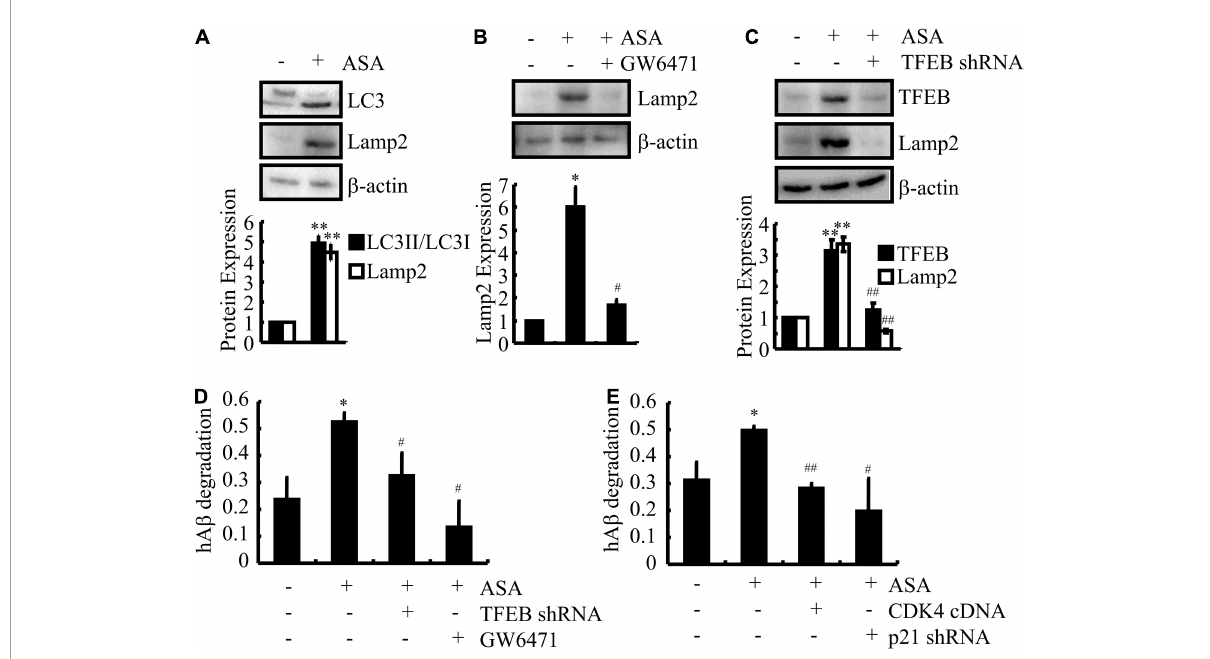
FIGURE6 Aspirin induces the degradation of A β in astrocytes. (A–D) D1A cells were transfected with TFEB shRNA or pre-treated with GW6471 (1 µ M) before incubating in ASA (10 µ M). (E) In select experiments, D1A cells were transfected with CDK4 cDNA and p21 shRNA before incubating with ASA (10 µ M). (A–C) The protein expression of LC3, Lamp2, and TFEB were determined by western blots. β -actin served as an internal control. The optical density of the bands was analyzed using ImageJ software. (D,E) The degradation of A β was determined by ELISA in astrocytes. Data are presented as the means ± S.E. of independent experiments, ∗ p < 0.05; ∗∗ p < 0.01 compared to vehicle-treated controls, # p < 0.05; ## p < 0.01; compared to ASA-treated